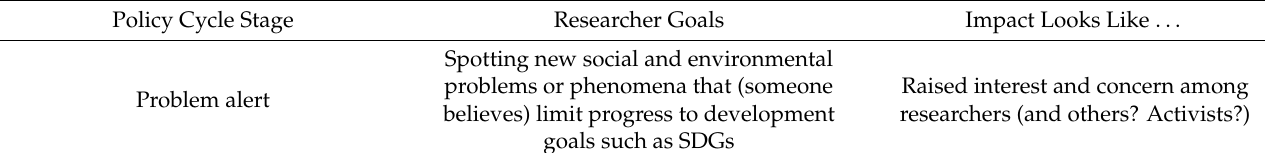
Table 3. Achievable goals for researchers interacting with policy issue cycles stages [109]. Policy Cycle